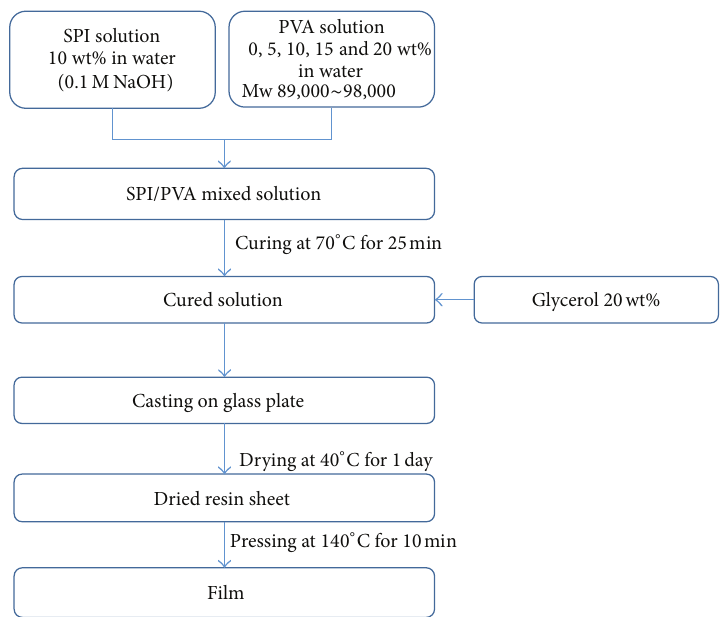
Figure 2: Manufacturing process of the SPI/PVA